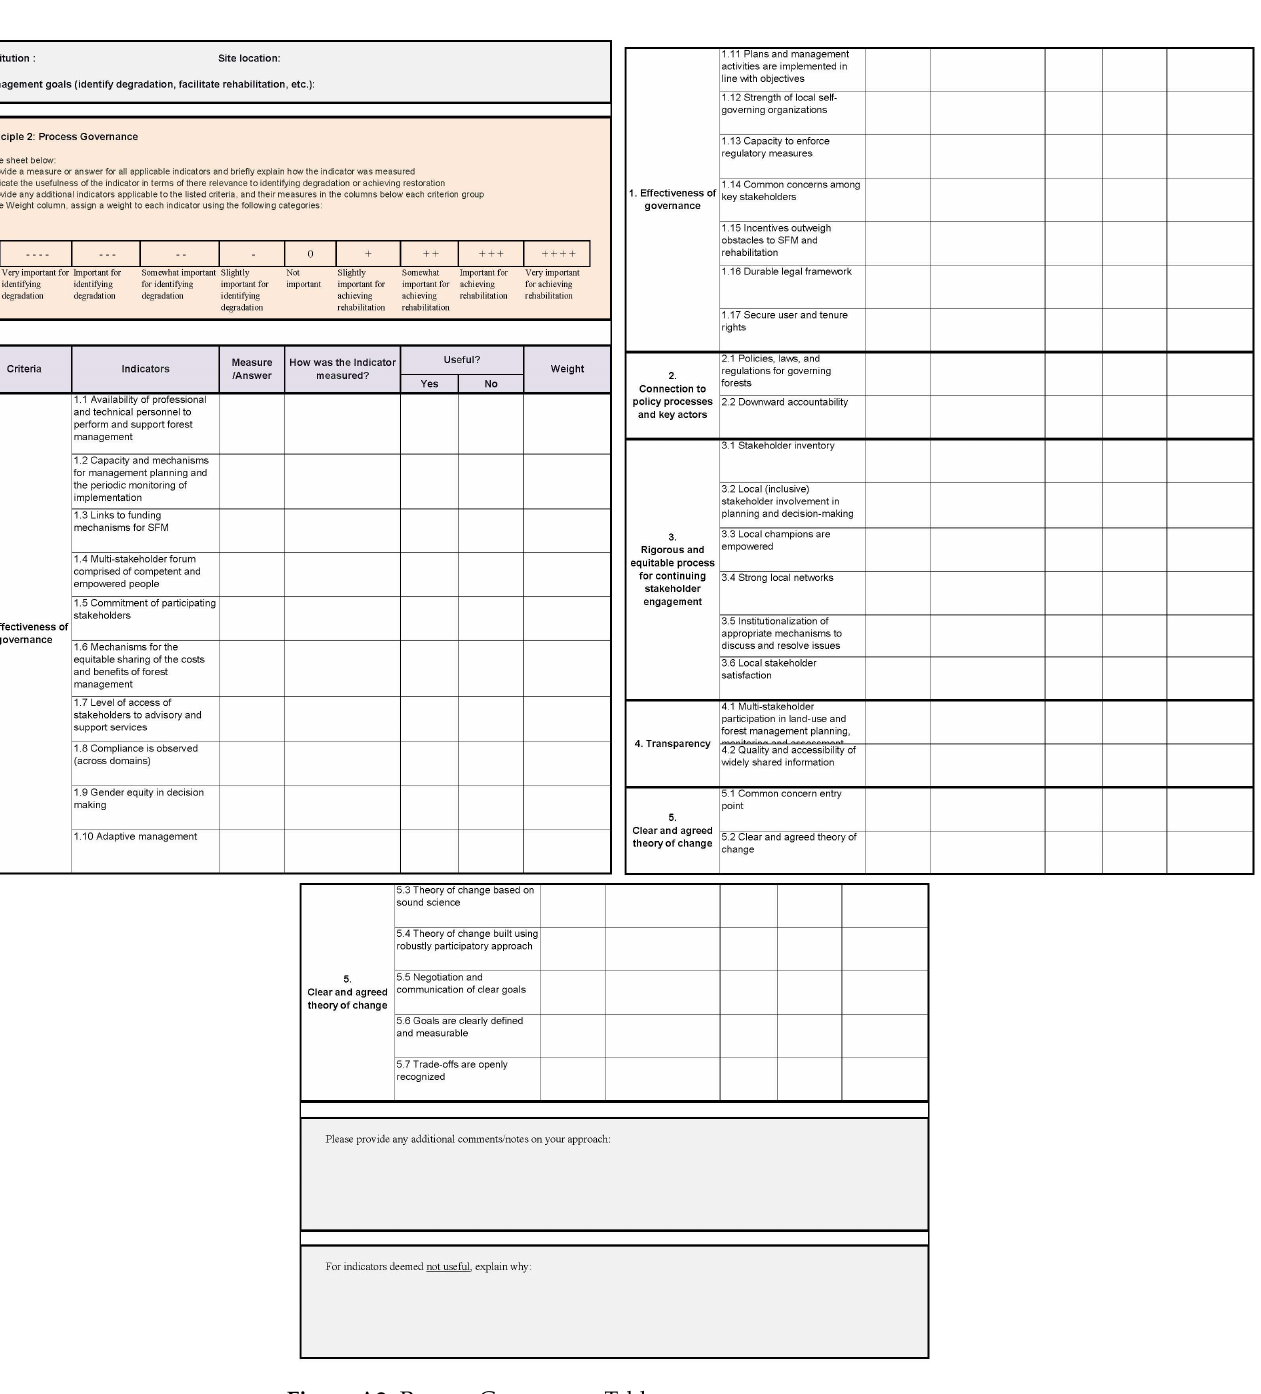
Figure A2. Process Governance Table.